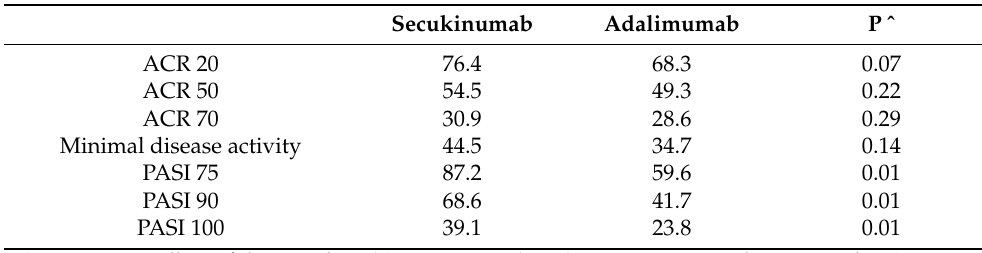
Table 1. Efficacy data of secukinumab and adalimumab at week 52 (%) from the EXCEED study.